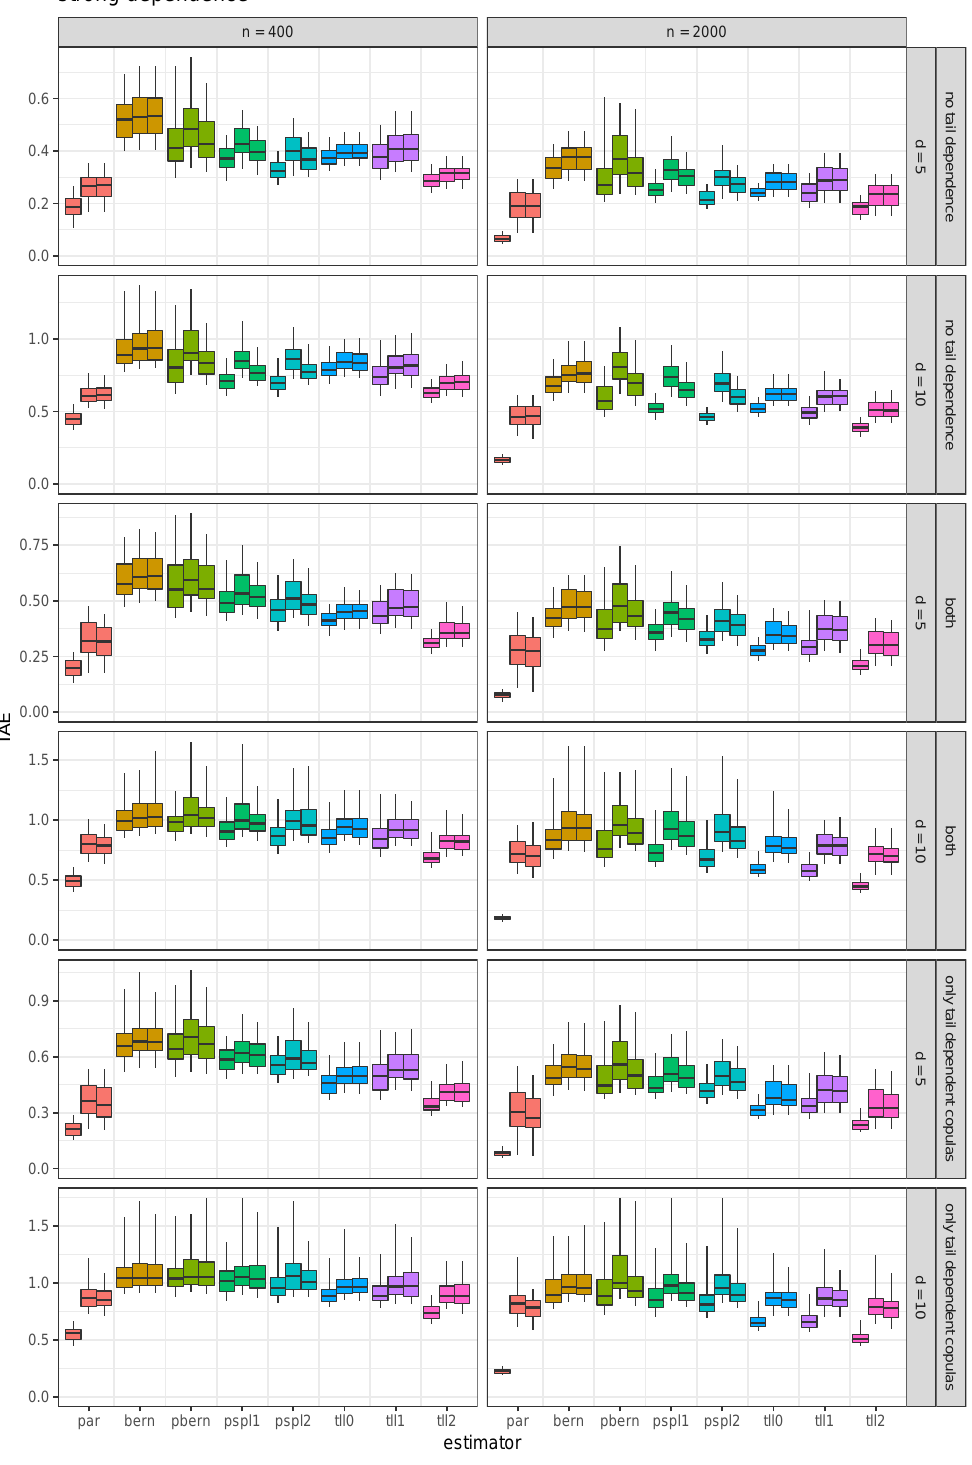
Figure 4: strong dependence: the box plots show the IAE achieved by each estimation method. Results are split by sample size, dimension, and type of dependence. Per estimator there are three boxes, corresponding to estimation under known structure, selection by Kendall’s τ , and selection by cAIC (from left to